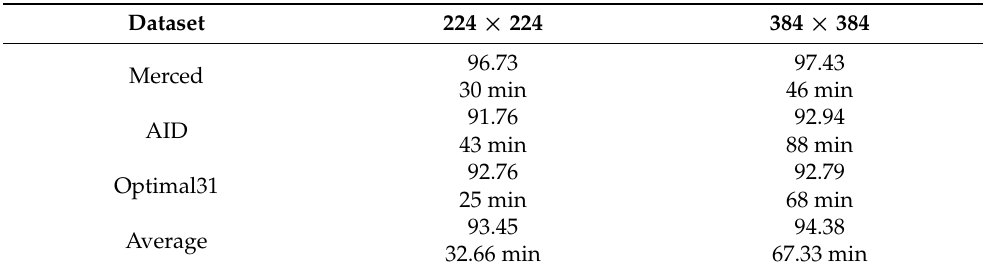
Table 4. Overall accuracies and training times obtained using different image size on different remote